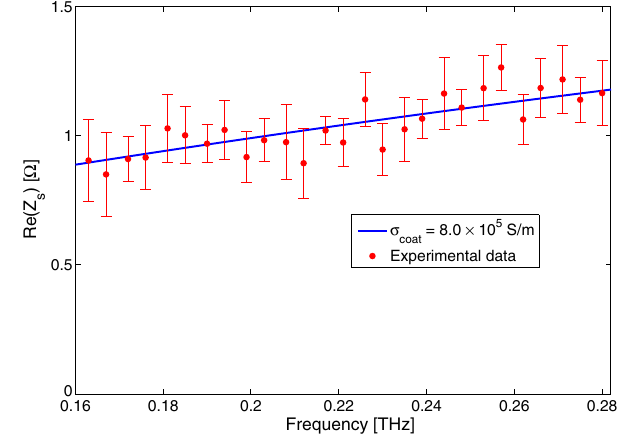
FIG. 14. Attenuation on the NEG coated slab of 3 . 96 μ m: averaged experimental data (red dots) and best fit curve (blue). The value of reduced χ 2 ¼ 0 . 40 .